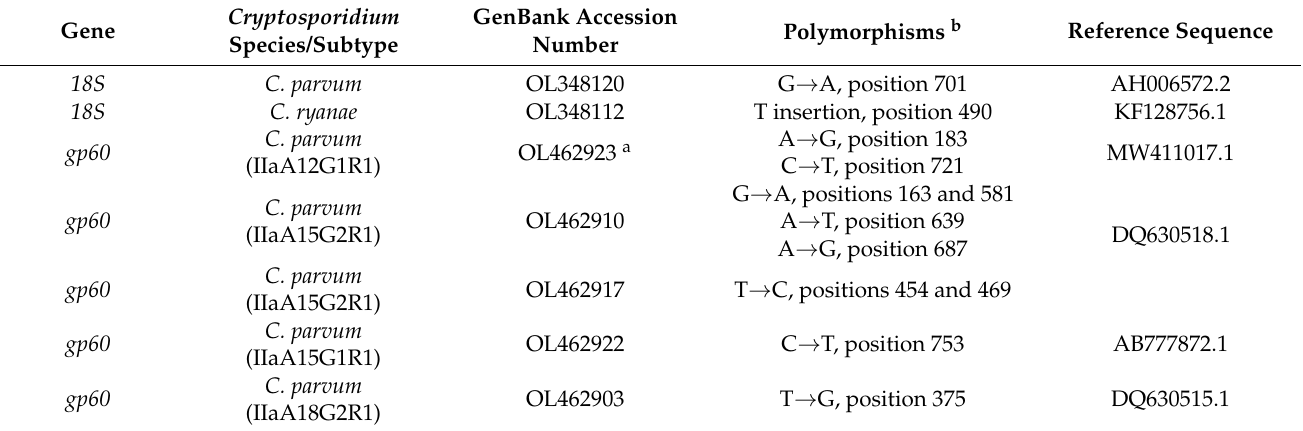
Table 3. Polymorphisms in Cryptosporidium 18S SSU rRNA and gp60 gene sequences showing intra-species genetic variability.